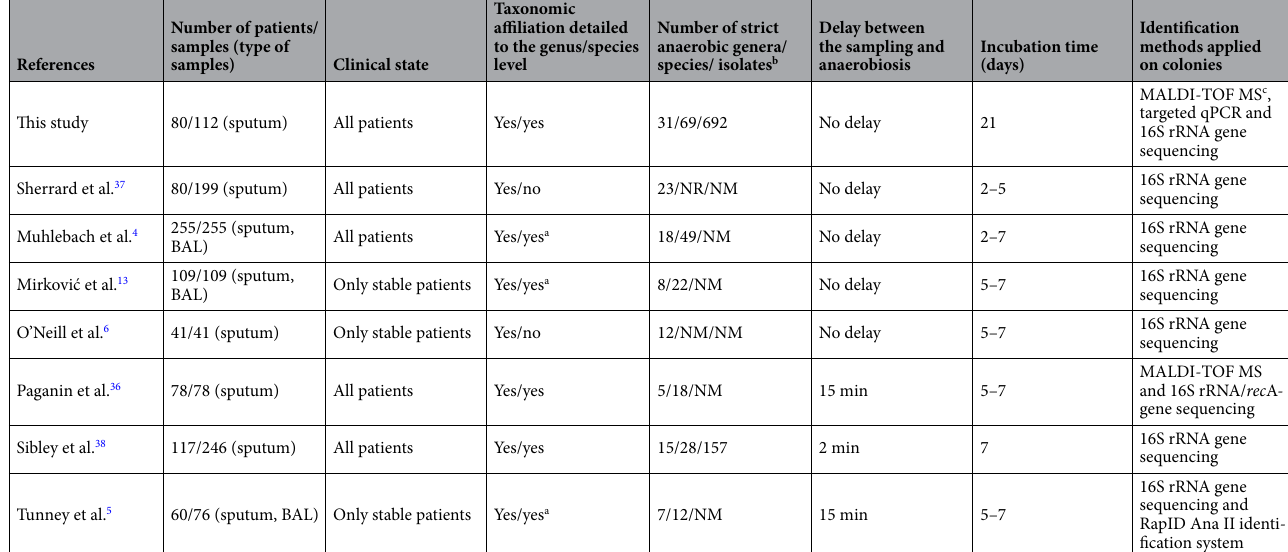
Table 3. Comparison of studies based on an extended-culture approach for the CF “anaerobiome” description. NR not realized, NM not mentioned, BAL bronchoalveolar lavage fluid, MALDI-TOF MS matrix-assisted